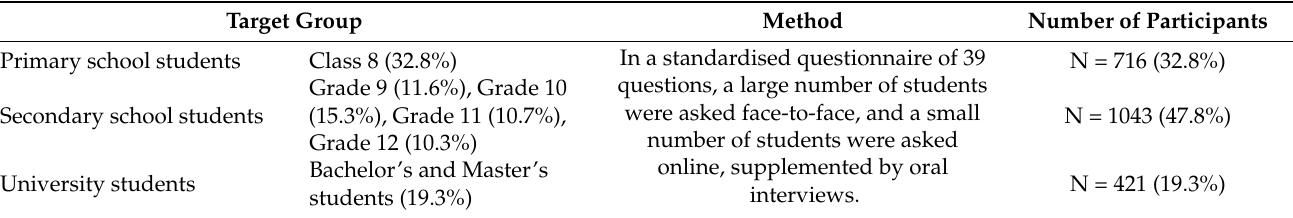
Table 3. Distribution of students participating in the survey of primary